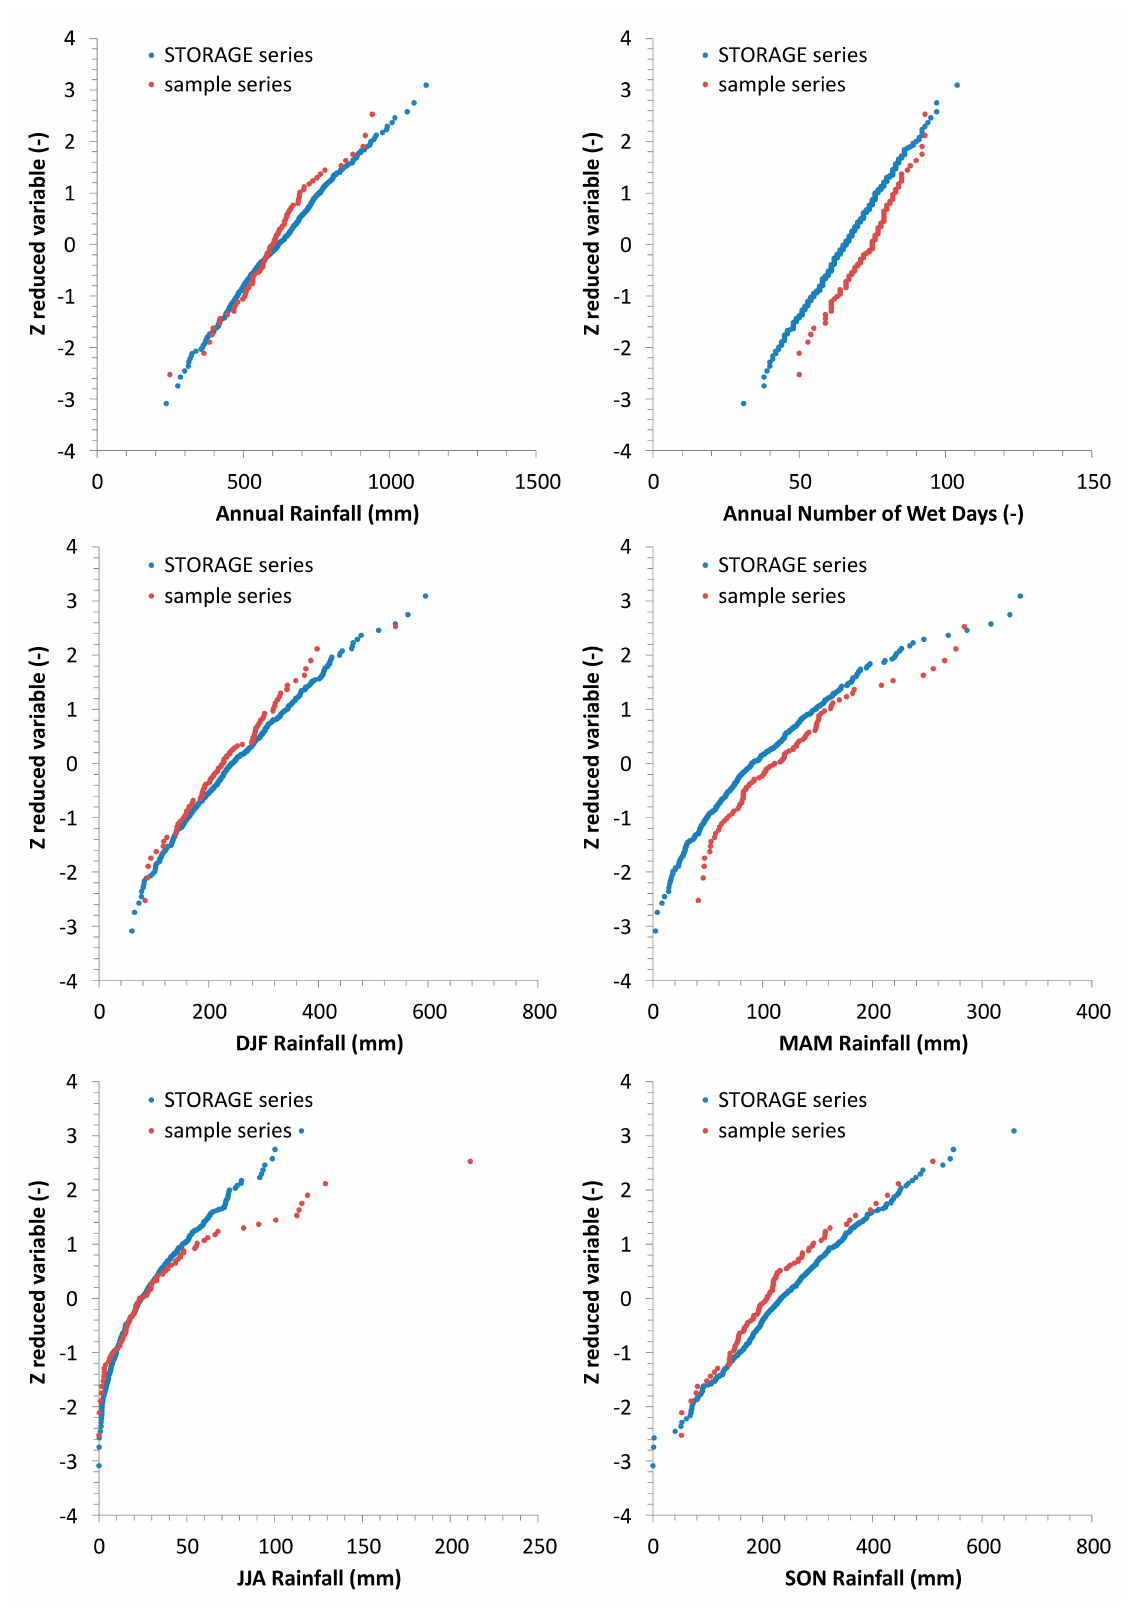
Figure 19. Reggio Calabria rain gauge: Gaussian probabilistic plots, showing the comparison among synthetic and observed series, regarding annual and seasonal rainfall, and annual number of wet